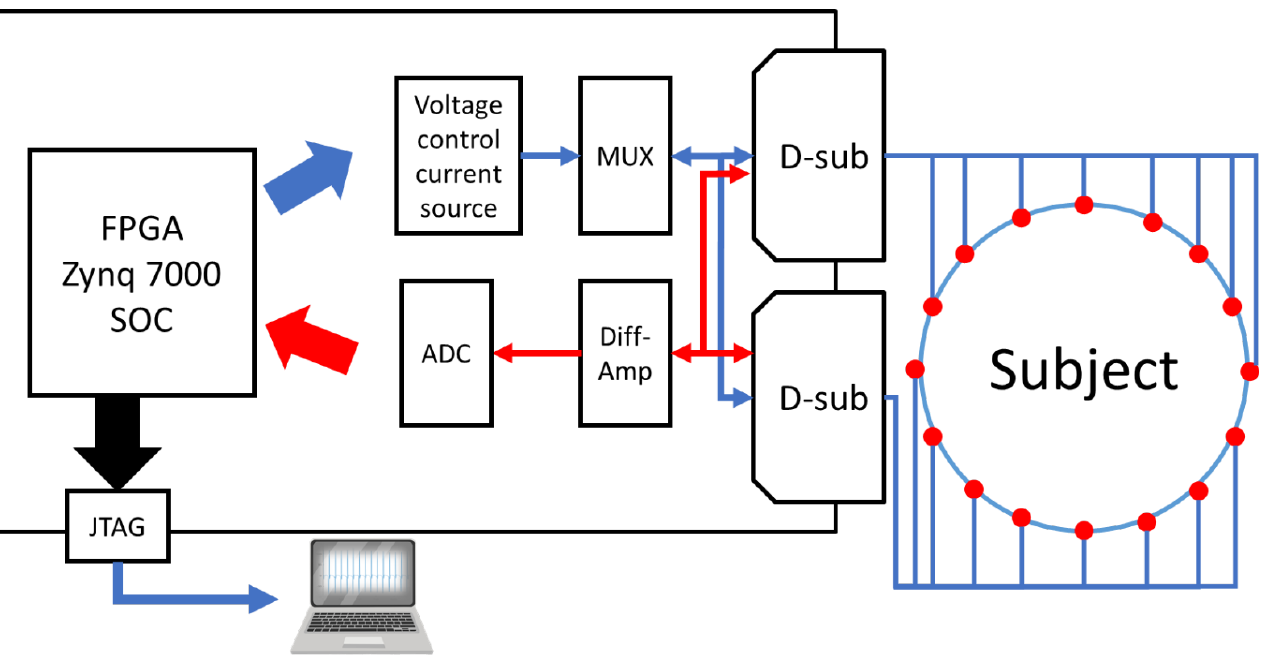
Figure 7. Block diagram of the portable EIT system.